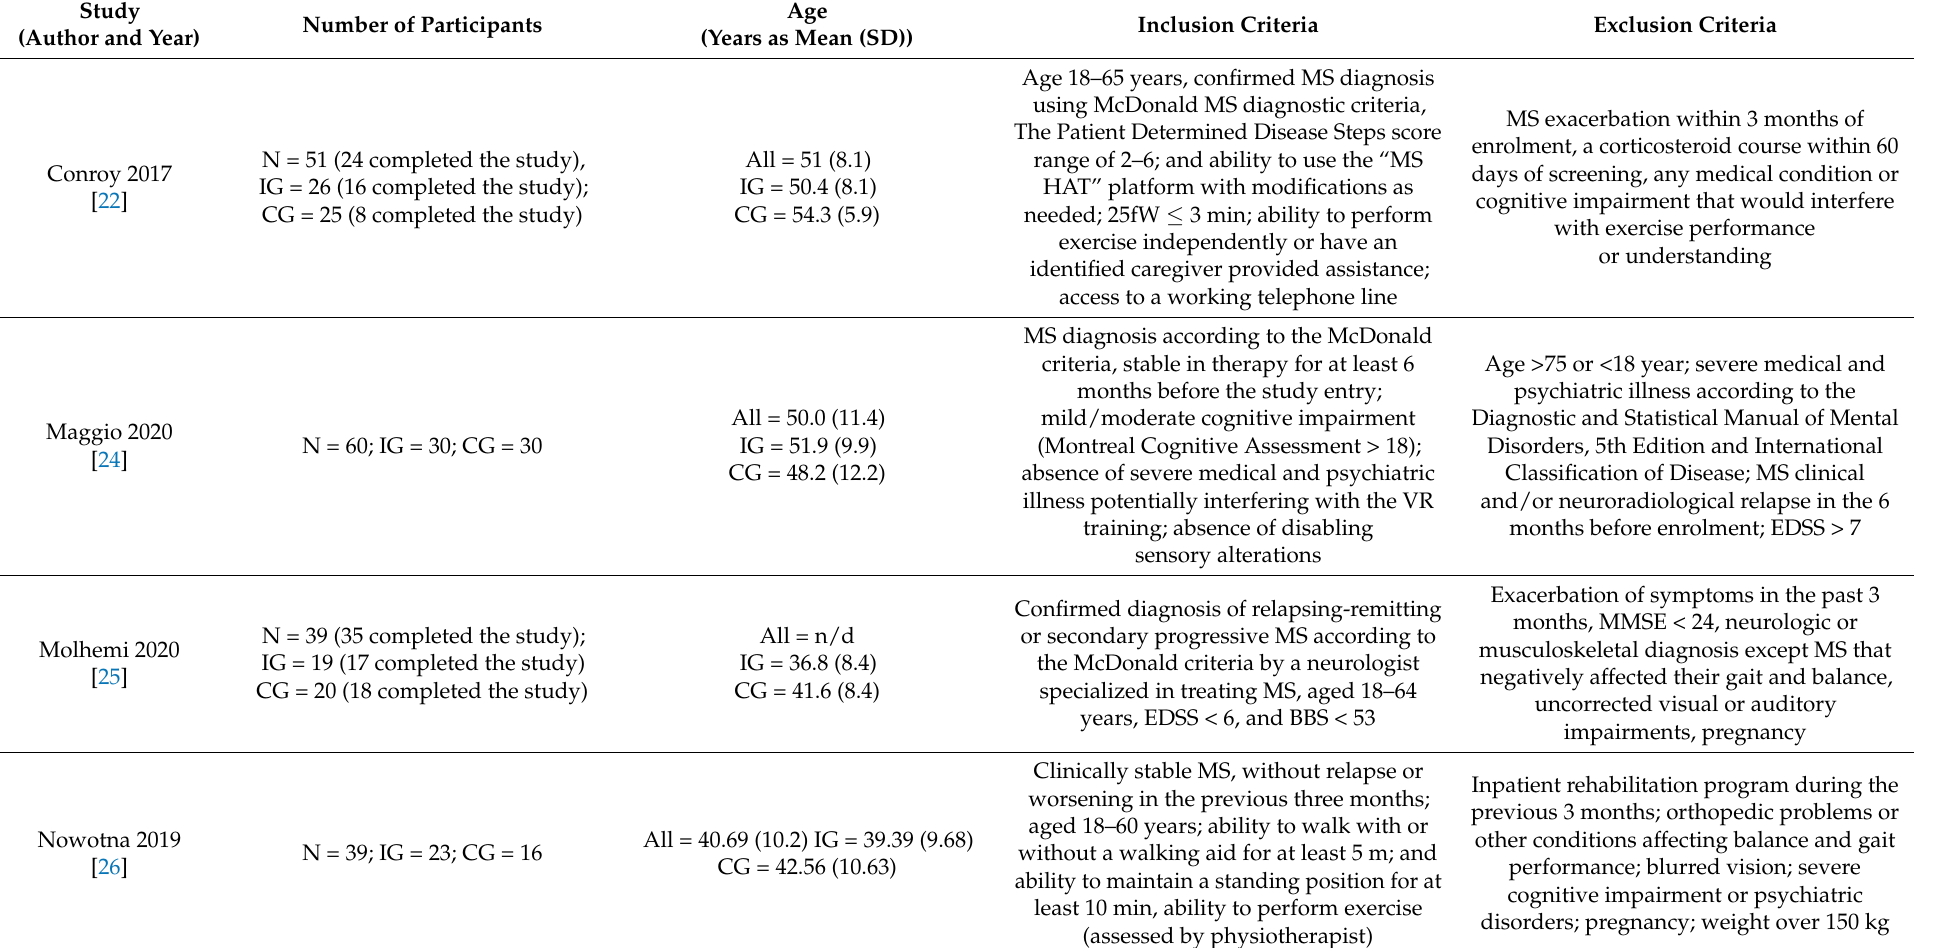
Table 2. Characteristics of research participants in studies of new technologies and balance and gait parameters in MS patient